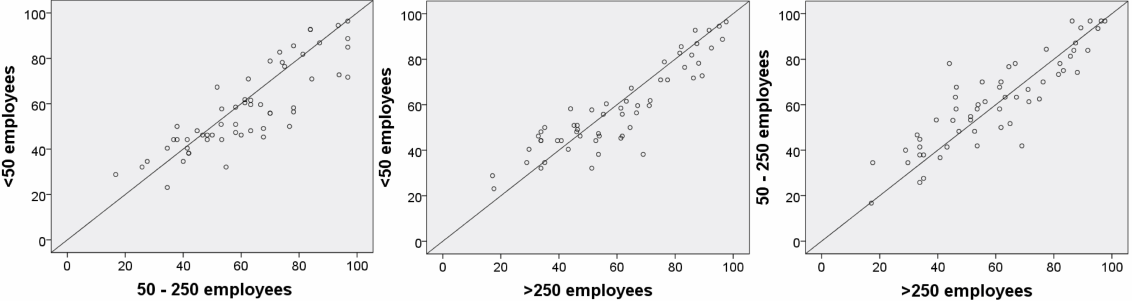
Fig. 3. Distribution of benefits/risks by enterprise size.